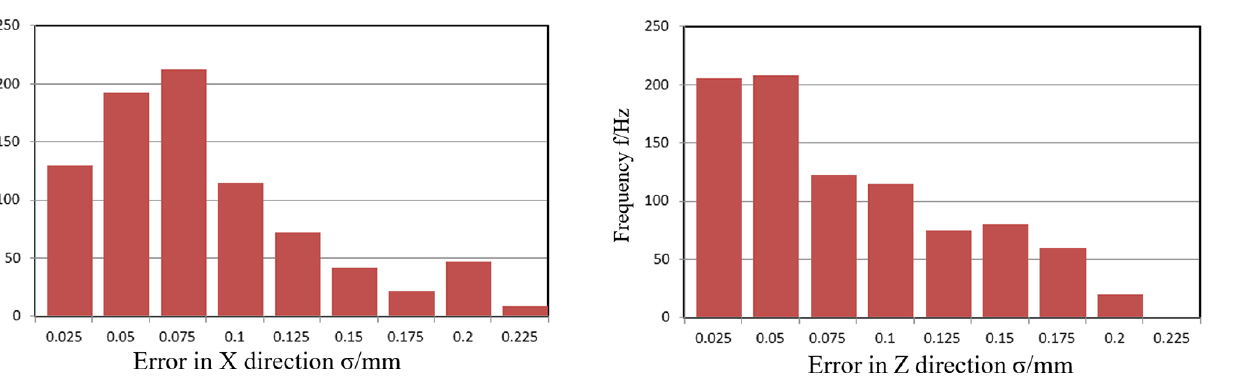
Figure 7. Frequency histogram of position error on working point in (0, 0, 1000) by error independent method.